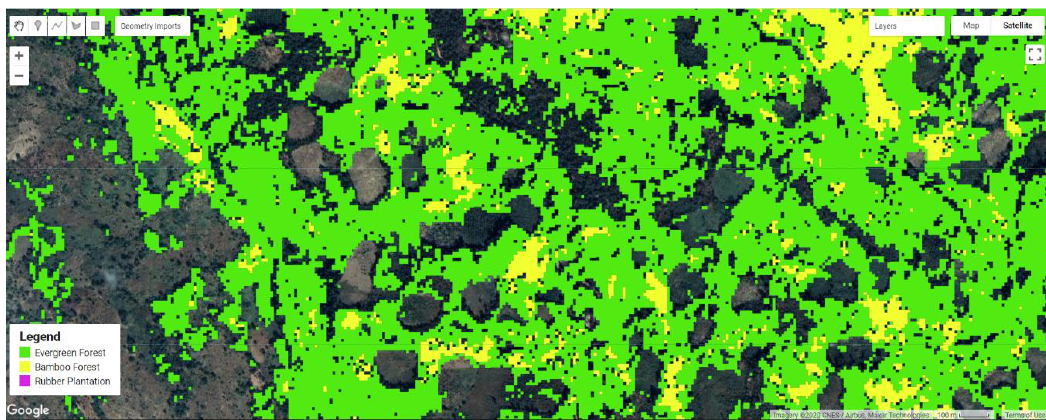
Table 4. Total carbon stocks and emission reductions in bamboo forests by districts in Siem Reap Province in 2015, 2018, and 2019. District Name